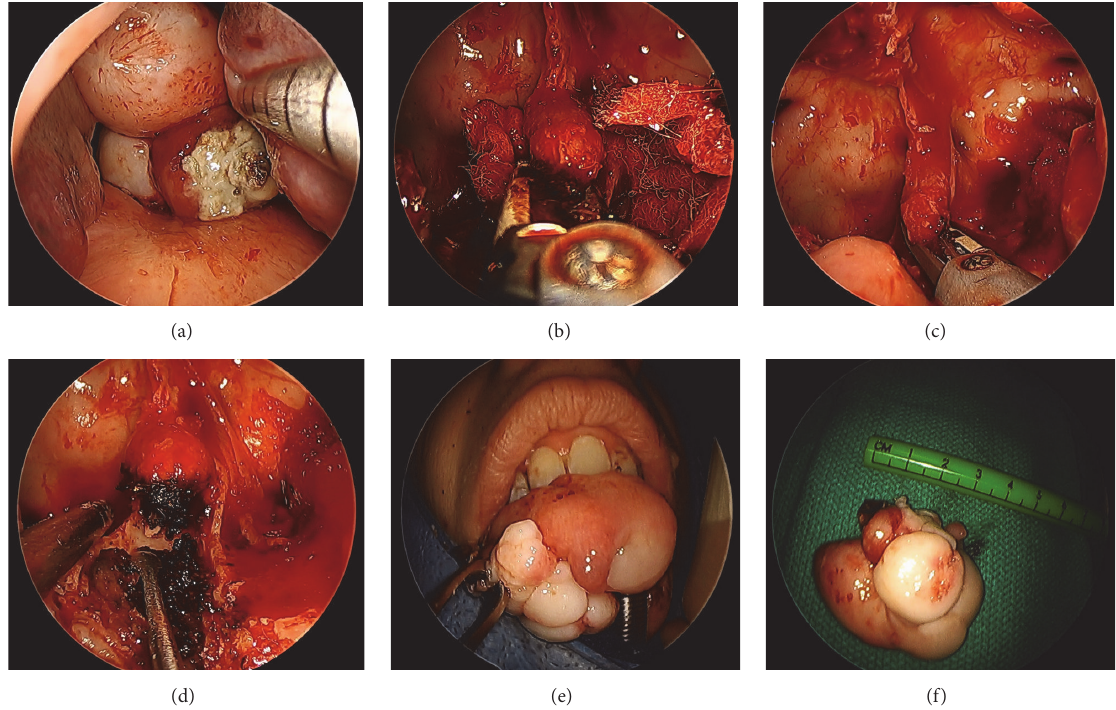
Figure 5: Surgical resection of skull base teratoma with ultrasonic bipolar diathermy. Endonasal view of the pedunculated skull base teratoma obstructing the posterior nasopharynx, with metal suction tip retracting the left inferior turbinate (a). Following sphenoidotomies, the tumor pedicle is approached (b), clamped in a full-thickness manner (c), and completely transected (d) using the vice-clamp tip and combined ultrasonic/bipolar platform energies. Teratoma passed into the oral cavity for transoral en bloc tumor removal (e), with lesion measuring approximately 4.0 cm in diameter